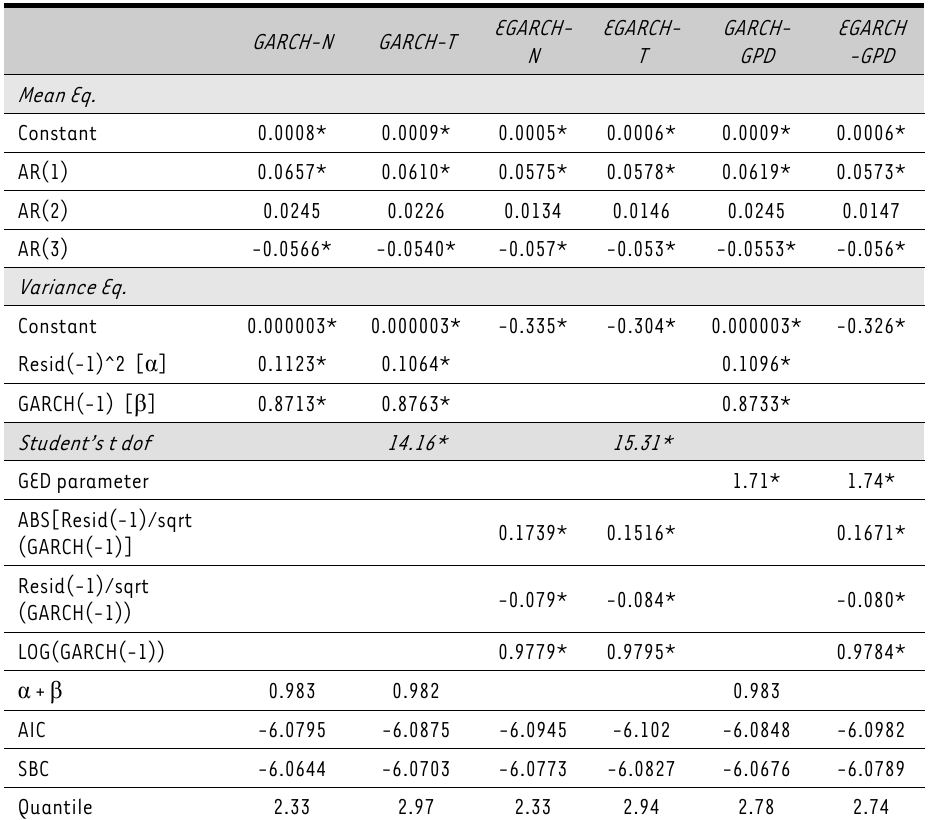
Distribution and GARCH type